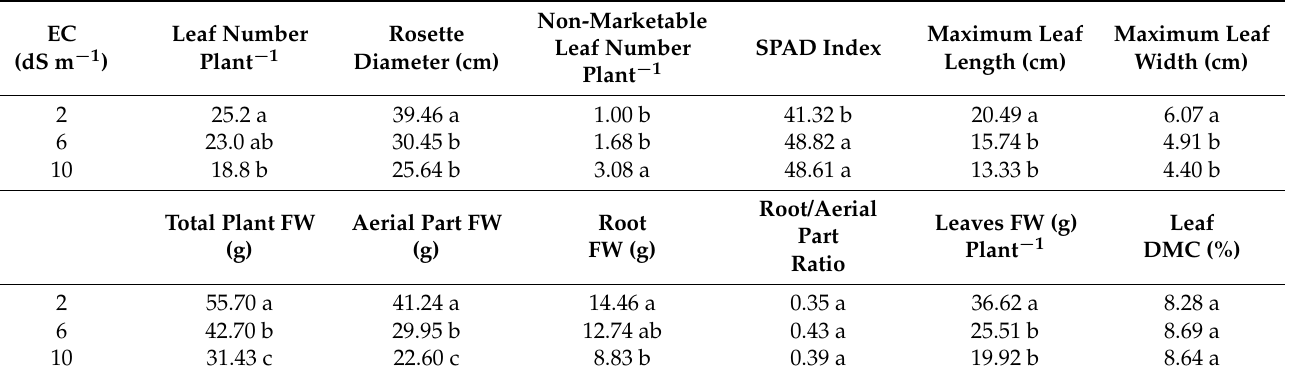
Table 2. Growth parameters of Urospermum picroides plants grown under different electrical conduc- tivity (EC) levels (2, 6, and 10 dS m − 1